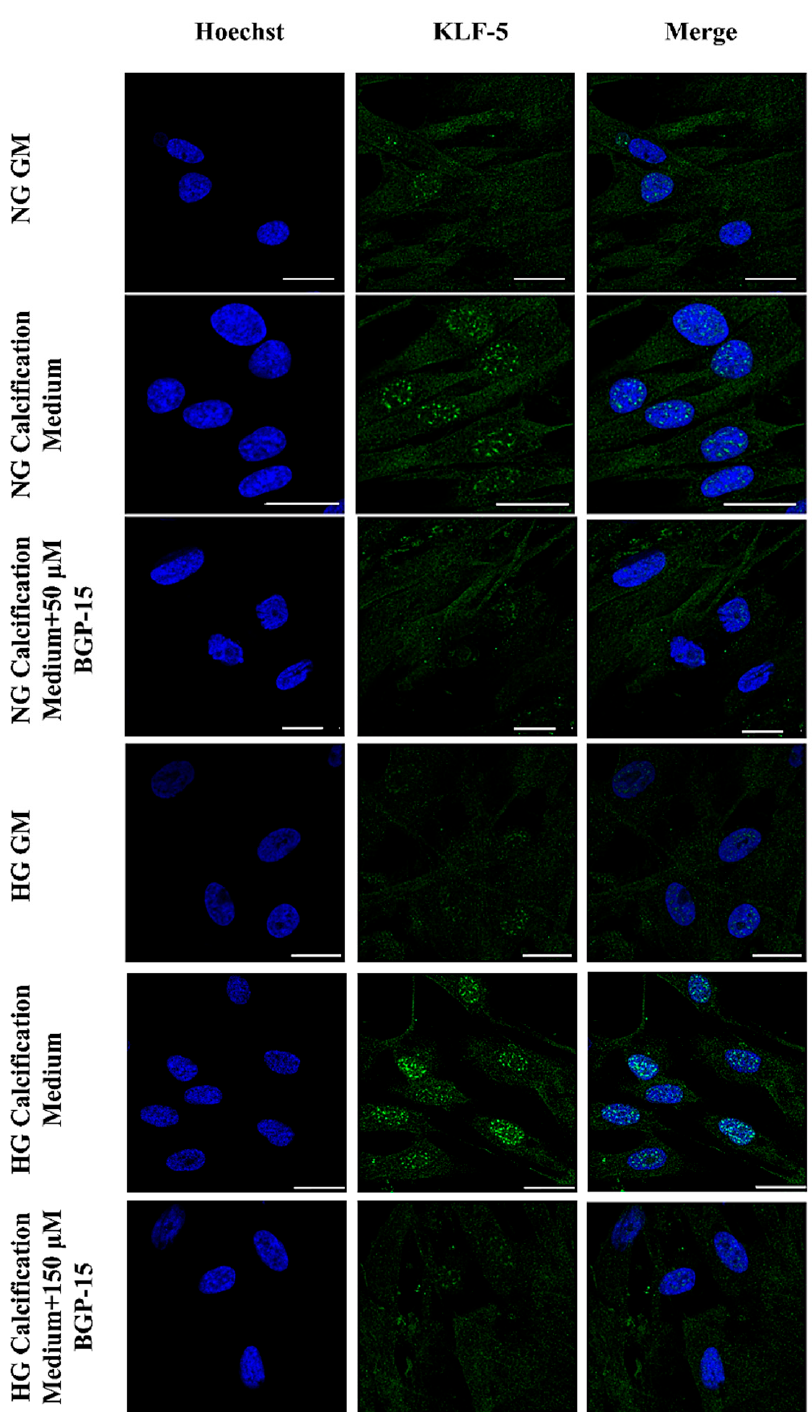
Figure 6. BGP-15 decreases nuclear translocation of KLF-5 induced by high Pi in NG and HG conditions. VSMCs were treated as in Figure 2 using 50 µ M BGP-15 under NG and 150 µ M under HG conditions for 10 days, then plated to glass coverslips. Nuclear translocation of KLF-5 was analyzed by immunofluorescence. Nuclei were counterstanied with Hoechst staining. Bar represents 25 µ